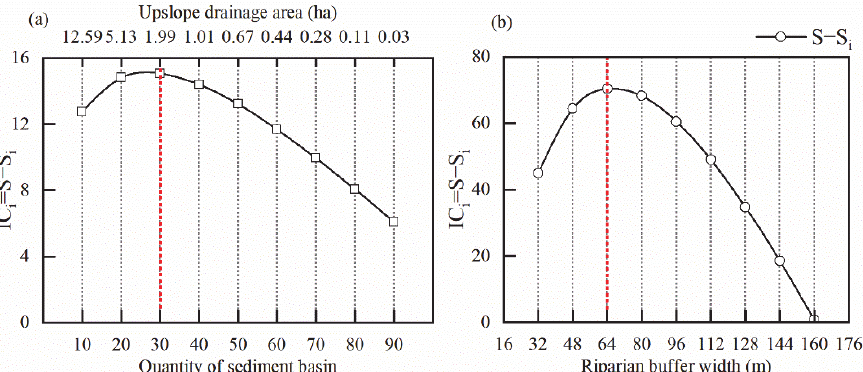
Figure 10. Variation curve of the difference between S and Si for the sediment basin (upslope drainage area) scenarios ( a ) and the riparian buffer scenarios ( b ) based on mean change point method.